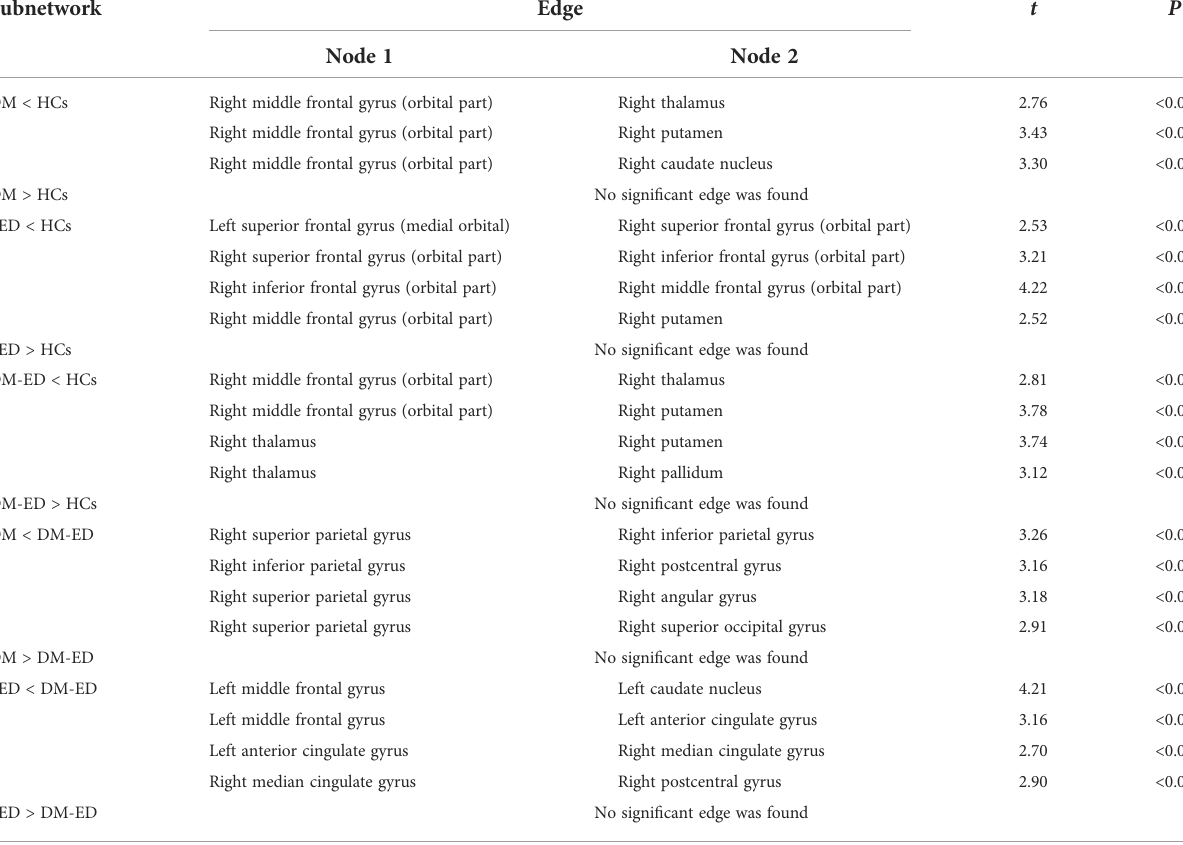
TABLE 2 Subnetworks identi fi ed to be signi fi cantly different among the DM, pED, DM-ED, and HC groups using network-based statistical analysis.